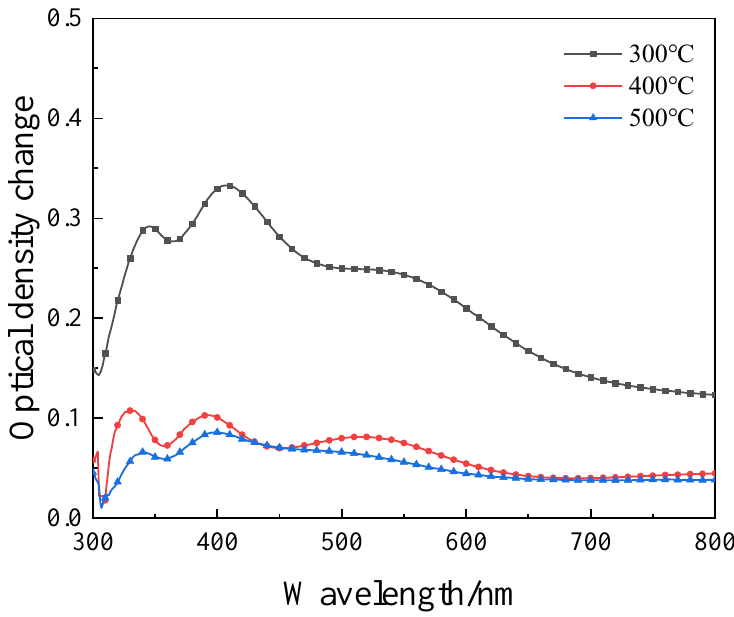
Figure 6. ΔOD of NiO thin films with different annealing temperatures as a function of wavelength.